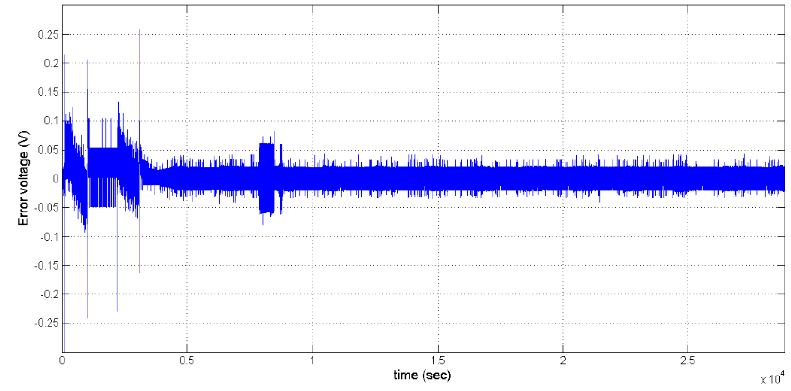
Figure 12. The error in voltage between the measured output and the estimated output.